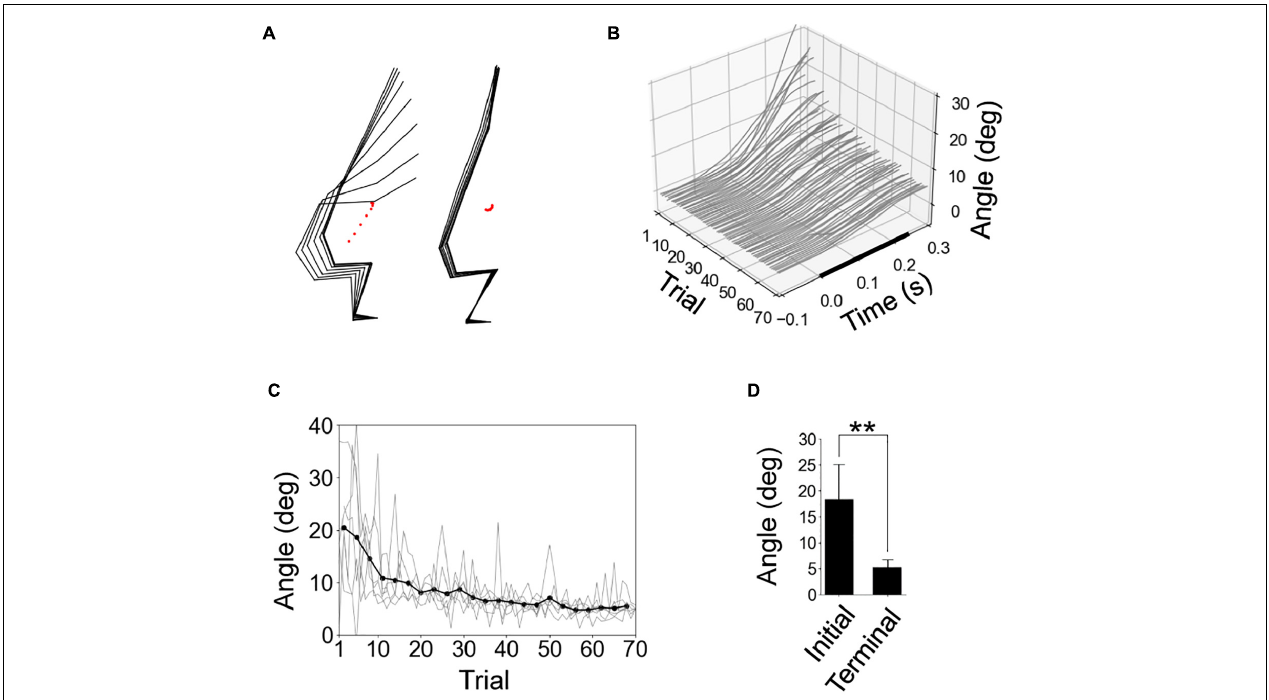
FIGURE 3 | Reduction of postural response due to experience of tilting trials. (A) Stick pictures of first and last trials in a representative rat. The period from the start of floor tilt to 0.28 s later was shown using black-point markers in Figure 1C . (B) . Time series of center-of-mass (CoM) angles of all 70 trials in a representative individual, with the start time of the tilting at time 0. (C) Fluctuation in CoM angle from the start of tilt to 0.3 s later for all individuals (gray line; n = 6) and the average (black line, the averages of 3 peripheral trials). (D) Statistical comparison of fluctuation in CoM angle from the start of tilt to 0.3 s between the average of initial and terminal eight trials by paired t -test ( n = 6). ** P <